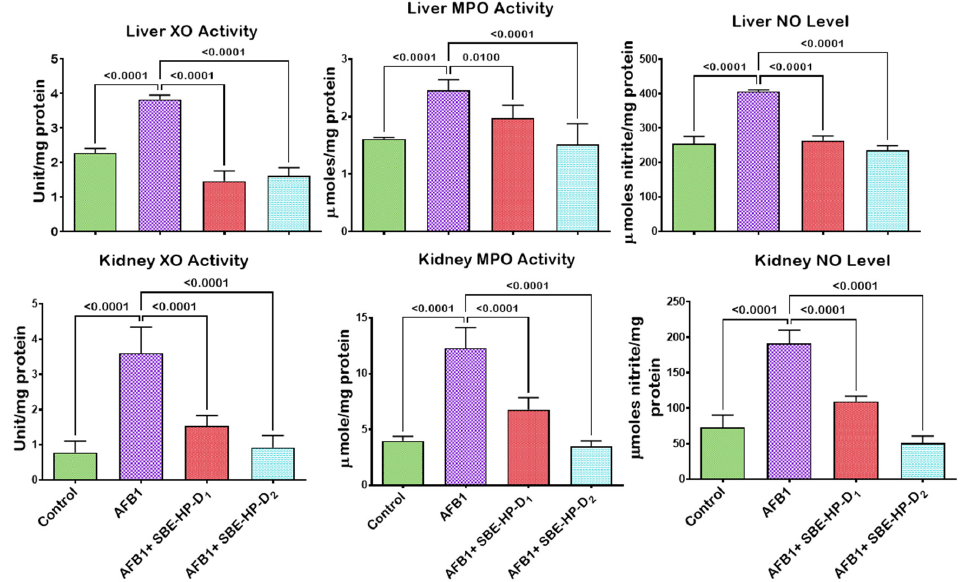
Figure 8. E ff ect of SBE-HP on the tissue concentrations of XO, MPO, and NO in the liver and kidney of rats treated with AFB 1 for 28 d. AFB 1 at 50 µg/kg; SBE-HP-D1 at 5 mg/kg; SBE-HP-D2 at 10 mg/kg. Values are expressed as mean ± SD for six rats per treatment cohort. Connecting lines indicate groups compared to one another. The signi fi cance level was set at (p < 0.05 ) ; p < 0.05 indicates the level of signi fi cance; p > 0.05: not signi fi cant. AFB 1 : A fl atoxin B1; D1: lower dose; D2: higher dose; XO: Xanthine oxidase; MPO: Myeloperoxidase; NO: Nitric oxide.